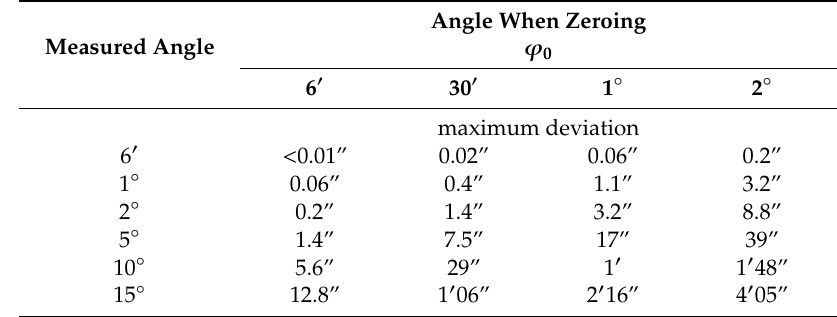
Table 10. Maximum deviation in a measured angle due to zeroing the reading at an angle ϕ 0 instead of ϕ = 0